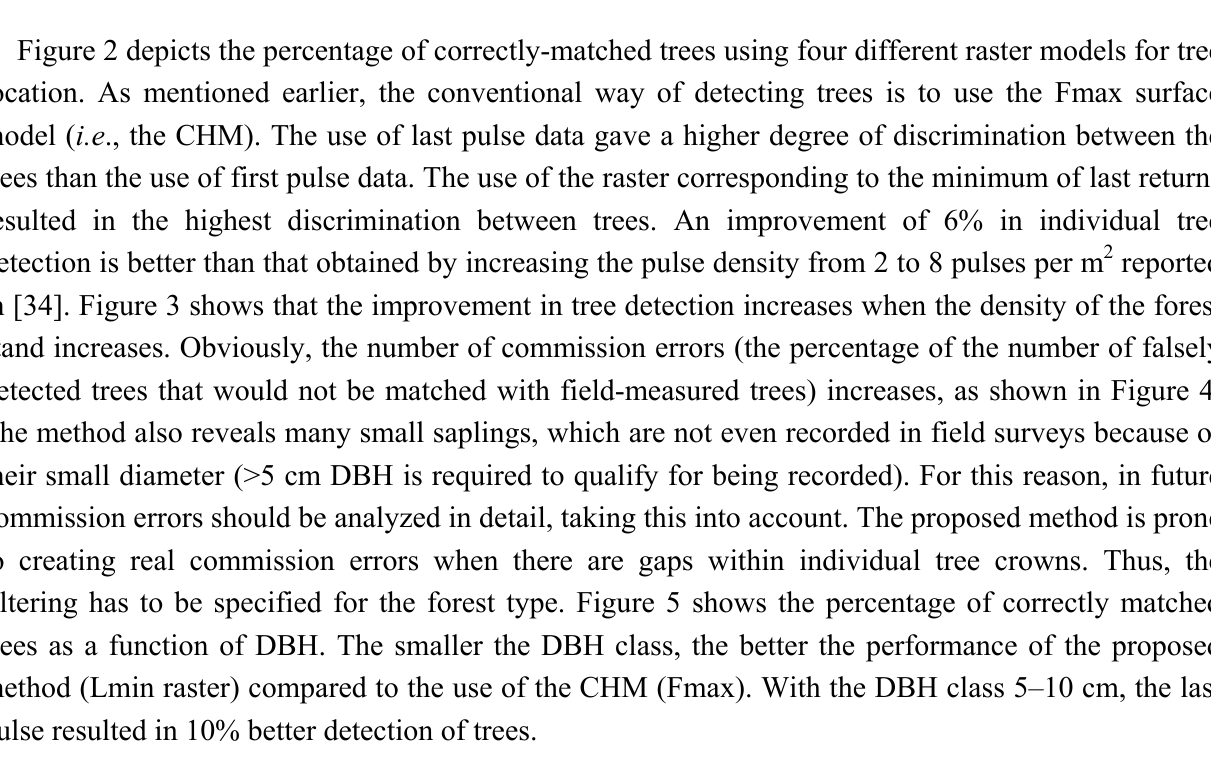
Figure 2. The percentage of correctly matched trees when tested with 5,532 trees surveyed in the